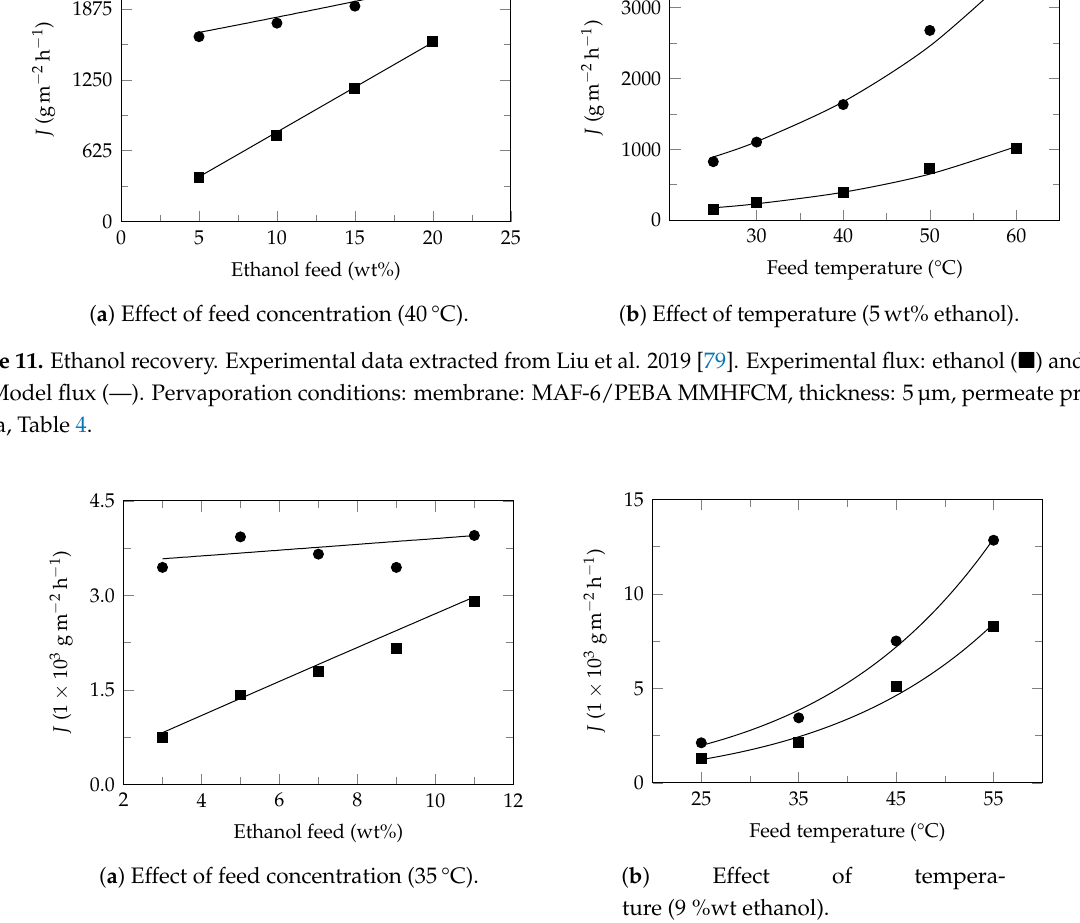
Figure 10. Ethanol recovery. Experimental data extracted from Mao et al. 2019 [66]. Experimental flux: ethanol ( (cid:4) ) and water ( (cid:32)